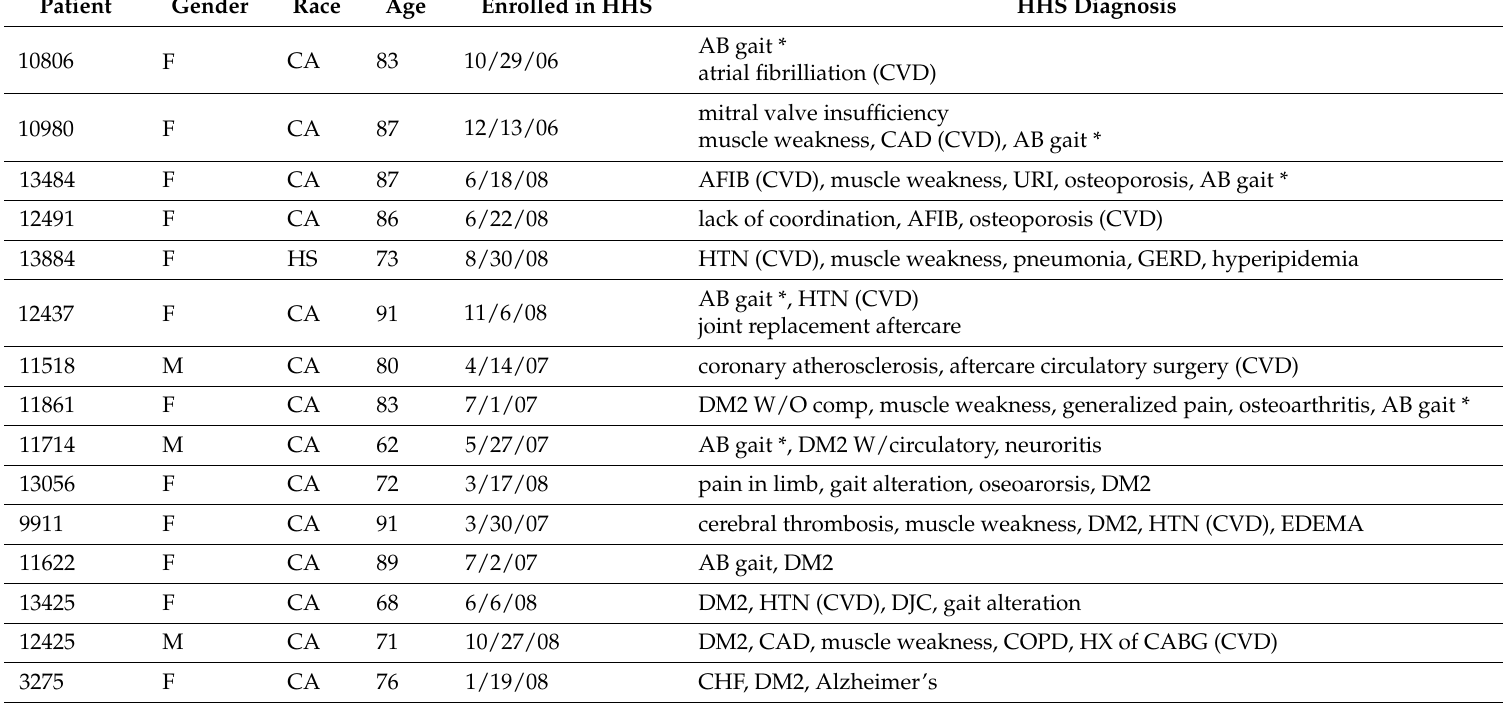
Table 4. Gender, Race, Age, HHS Enrollment Dates and HHS Diagnoses of Comparison Patients with No Emergent Care ( N = 16/36, 44.4%). Patient